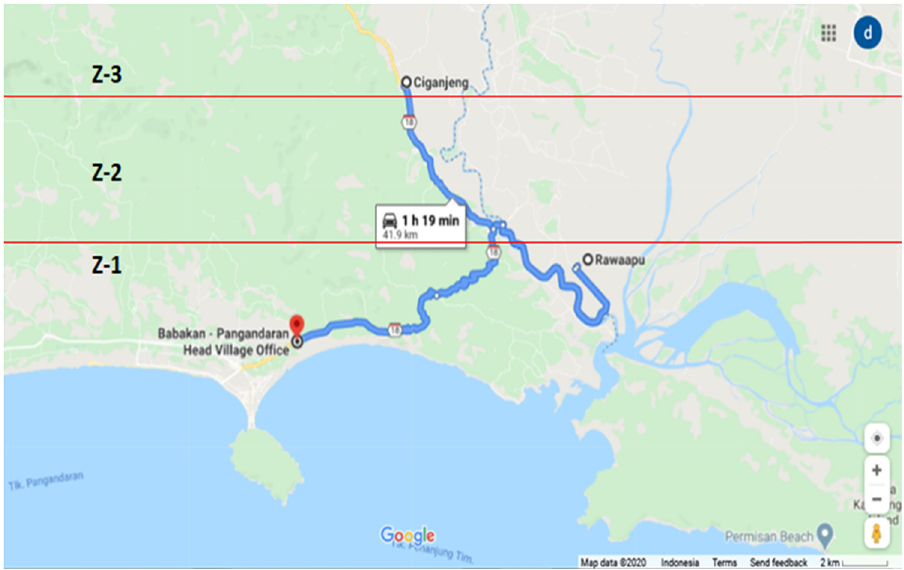
Figure 1: Distribution of research location